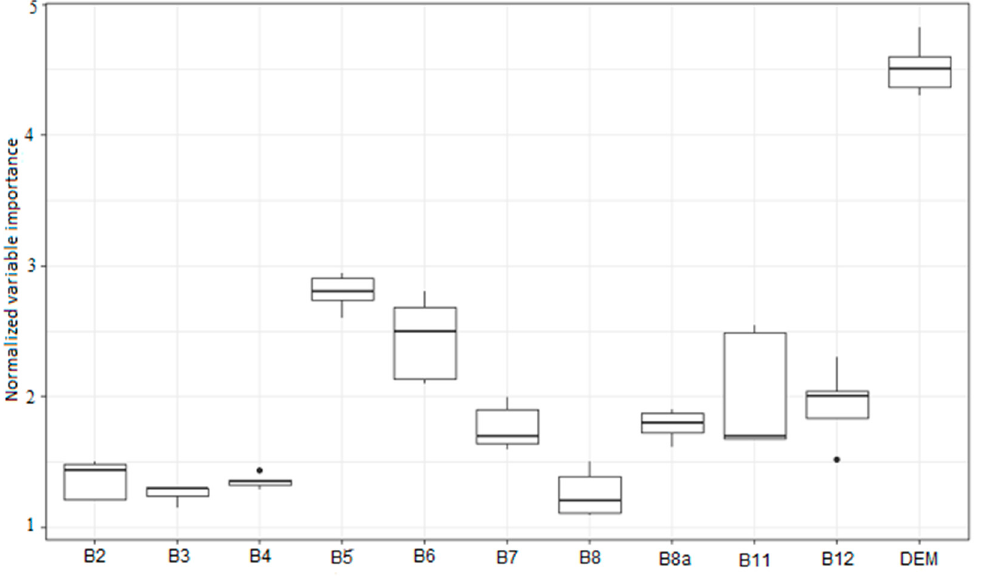
Figure 8. Normalized variable importance for the best classification of forest type derived using a combination of 10 m (B2, B3, B4, B8), 20 m (B5, B6, B7, B8a, B11, B12) resolution bands and DEM (11 variables).